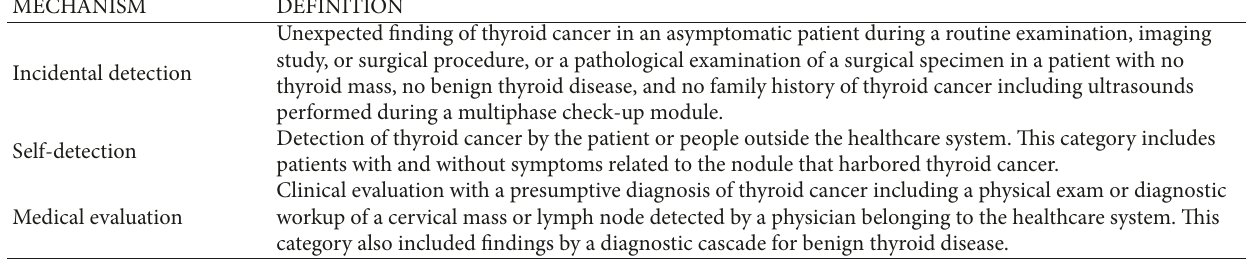
Table 1: Definitions of mechanisms of detection of thyroid